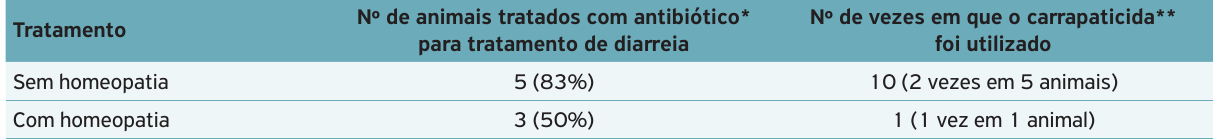
Tabela 3. Número de tratamentos alopáticos para diarreia e aplicação de carrapaticida em bezerras que receberam ou não